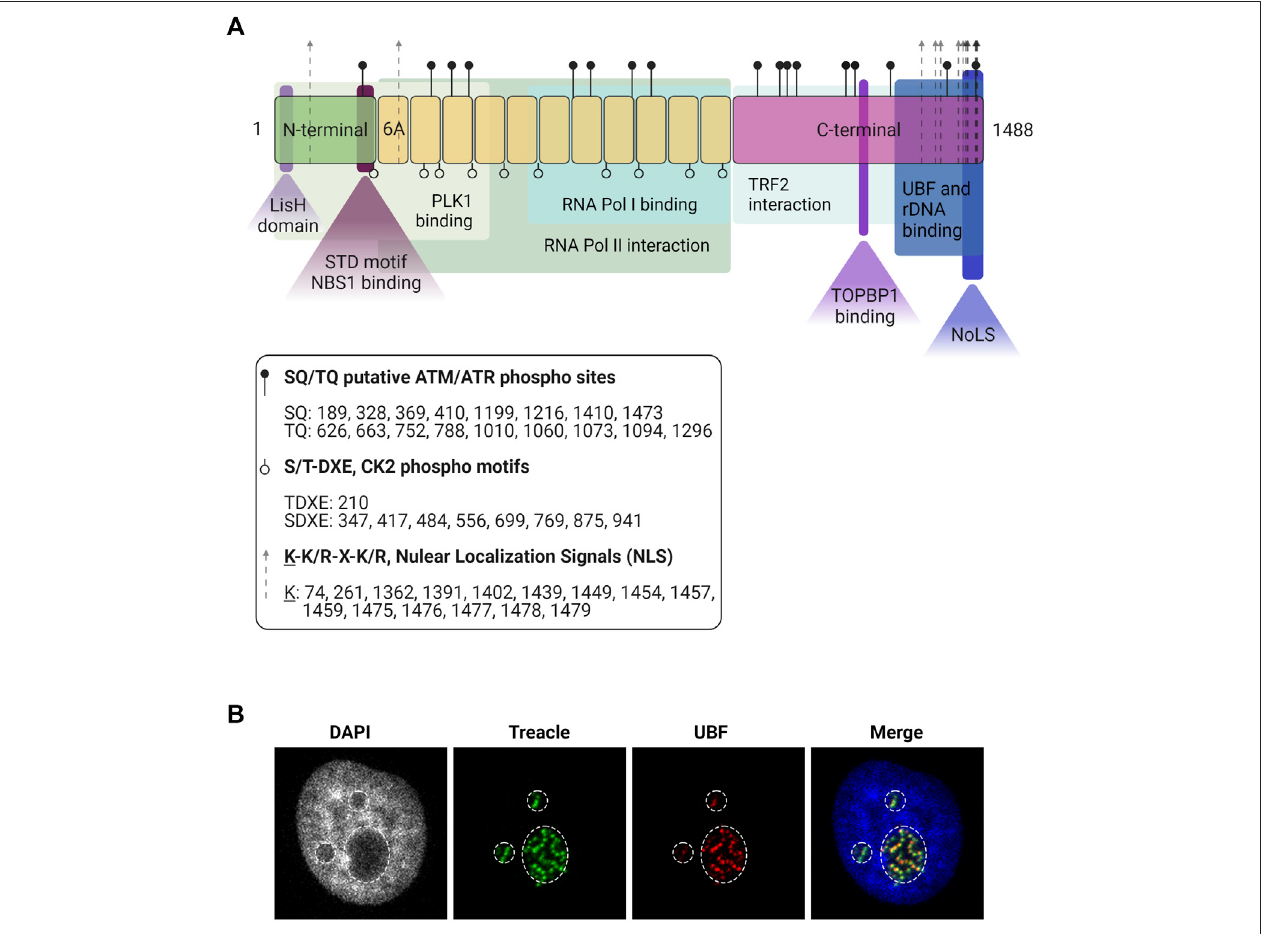
FIGURE 1 | Treacle structure and cellular localization. (A) The structure of the most common isoform of Treacle. Treacle isoform d (1488 amino acids, 152 kDa, NP_001128715.1) is encoded by the Treacle transcript variant 4, containing 27 exons. It is an intrinsically disordered protein with N- (exons 1 – 6, aa 1 – 213) and C-terminal (exons 17 – 26, aa 954 – 1,488) regions, and 11 central repeat domains (exons 6A – 16, aa 214 – 953). The N-terminal harbors a LisH domain (aa 6 – 38), and contains a nuclear localization signal (NLS, aa 74 – 77). The SDT-like motifs SETE (aa 171 – 174), SEDT (200 – 203), SDET (207 – 210), are responsible for NBS1 binding, and PLK interaction site was also mapped to the N-terminal domain. The 11 central repeats contain several CK2 and ATM/ATR phosphorylation sites. The central region is responsible for Pol II interaction, and aa 526 – 953 mediates Pol I binding. Repeat domain 6A furthermore contains a NLS but 6A is not present in all isoforms. The C-terminalregion isimportant for Treacle localization, it contains several potential NLSs (aa 1,362 – 1,482).The last 41aa ofthe protein mediatesnucleolar localization. The C-terminal furthermore mediates rDNA and UBF binding (aa 1,294 – 1,488). It contains several SQ/TQ phospho motifs, three serines (S1227, S1228, S1236) responsible for TOPBP1 recruitment, and a TRF2 interaction site. Created with BioRender.com. (B) Immuno fl uorescence images of Treacle and UBF in the dense fi brillar component, a sub-compartment of the nucleolus where newly transcribed rRNA is located. The nucleolar area is outlined based on lower intensity of the DNA (DAPI)